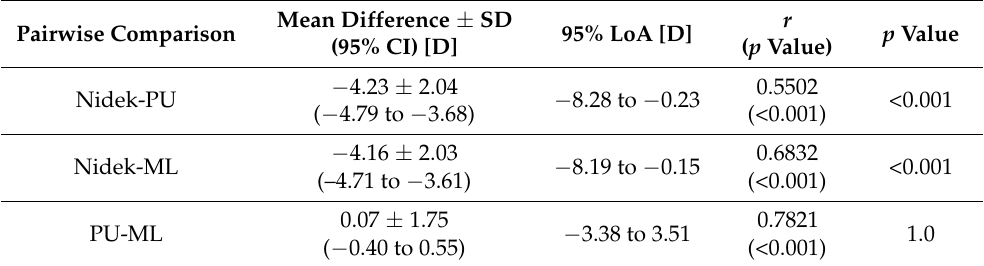
Table 1. Mean differences, 95% limits of agreement (LoA), correlation coefficient ( r ), and pairwise comparison between various methods for assessing the amplitude of accommodation (AA); ( n = 84 eyes).